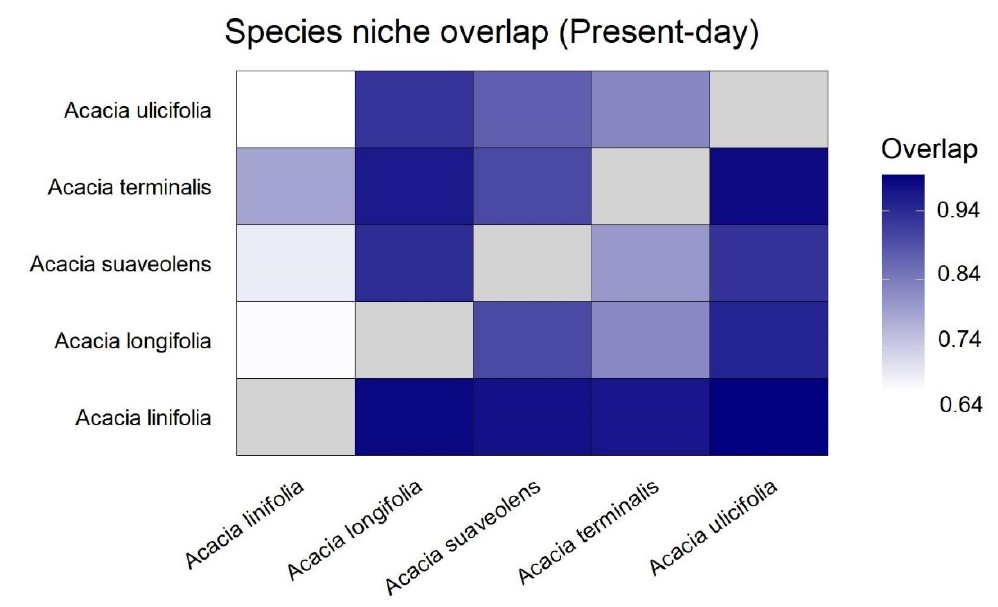
Figure 2. Environmental niche overlap between the five species of Acacia studied across eastern Australia. Overlap is directional, with values reflecting the size of the overlap of the species on the y -axis captured by the niche of the species on the x -axis. Overlap is scored between 0 and 1, with values near 0 indicating a small overlap and near 1 a large overlap. Results presented are the mean across n-dimensional hypervolumes calculated from five different sets of environmental variables and have a minimum overlap of 0.64.